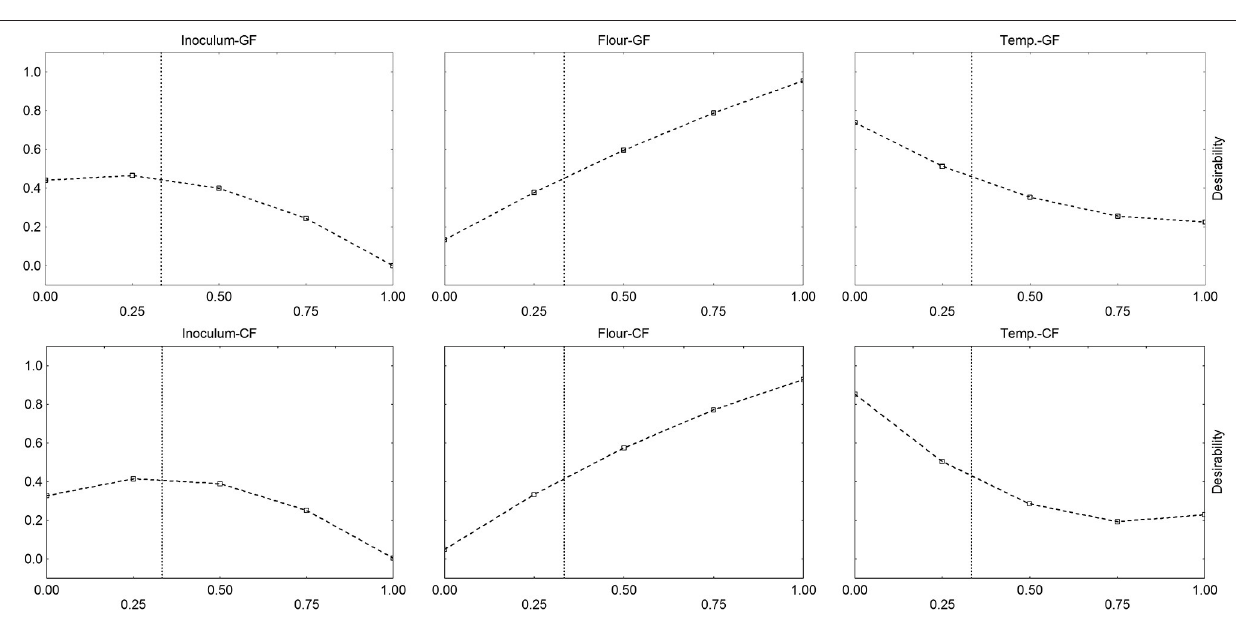
Frontiers in Microbiology |